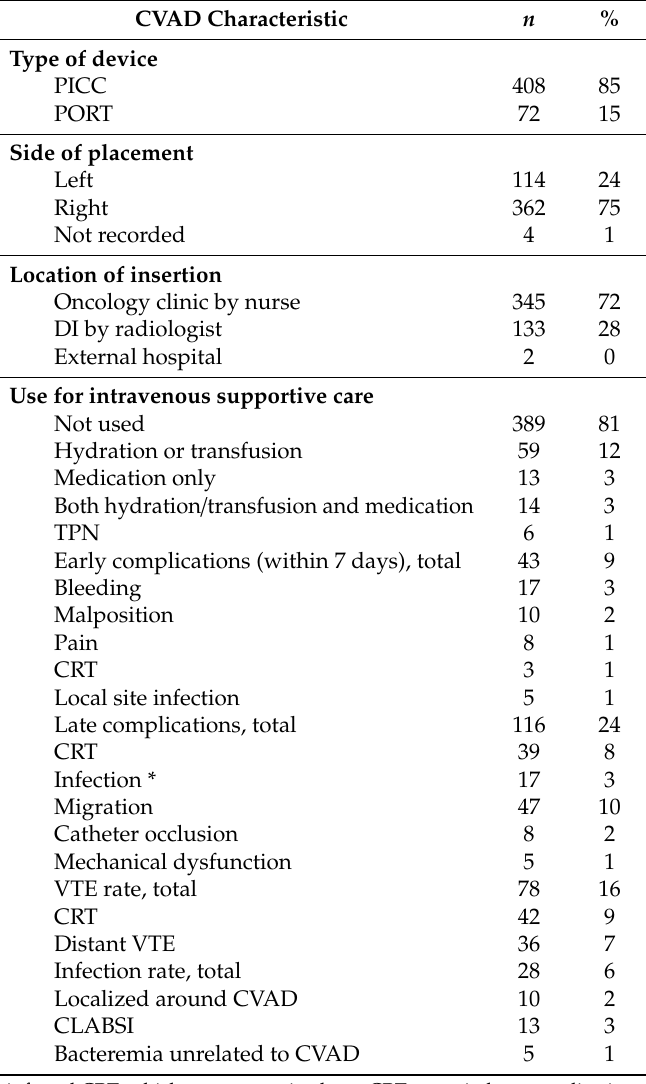
Table 2. CVAD characteristics ( n =